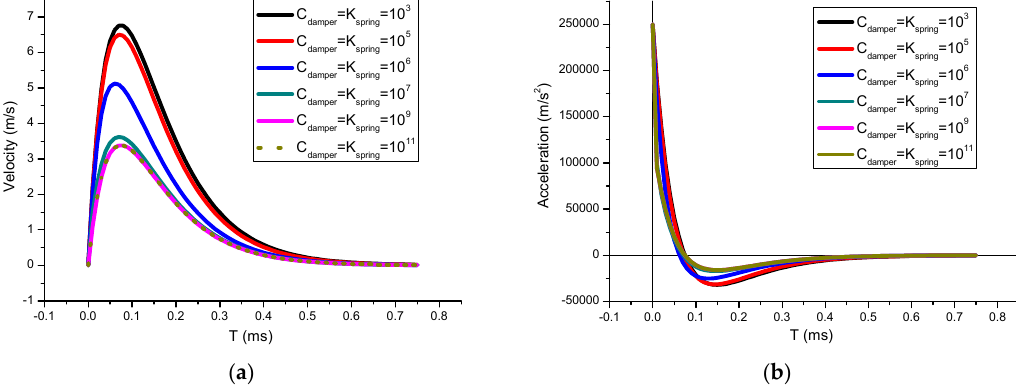
Figure 3. For different values of C damp and k, time histories of ( a ) the speed, and ( b ) the acceleration of the left plate.